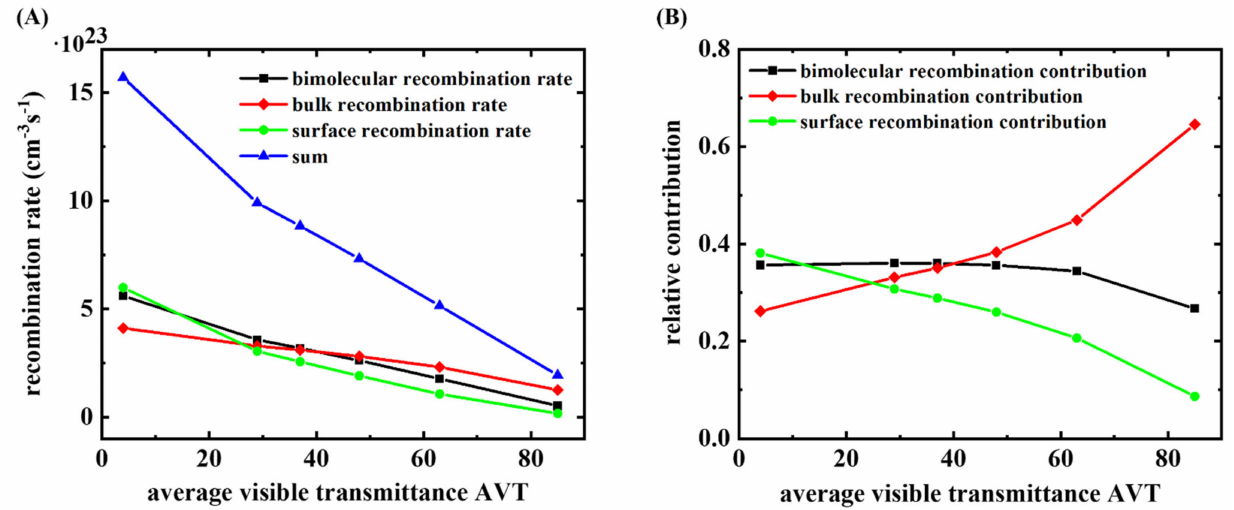
Figure 4. ( A ) Recombination rates in dependence on the AVT of the device stack and ( B ) the relative recombination contributions of the different recombination